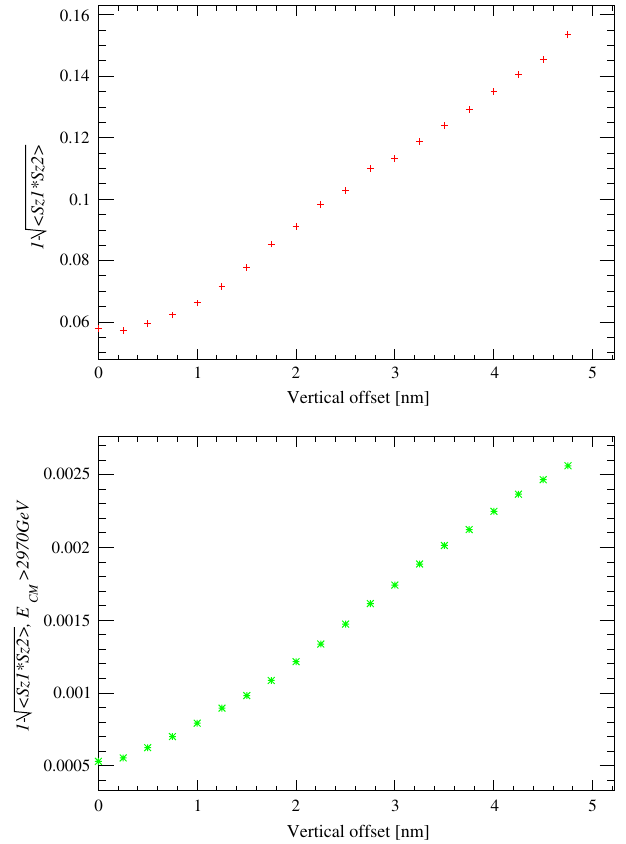
FIG. 17. Depolarization as function of vertical offset using Gaussian input beams. Top: total depolarization. Bottom: depo- larization within 1% of the nominal CM